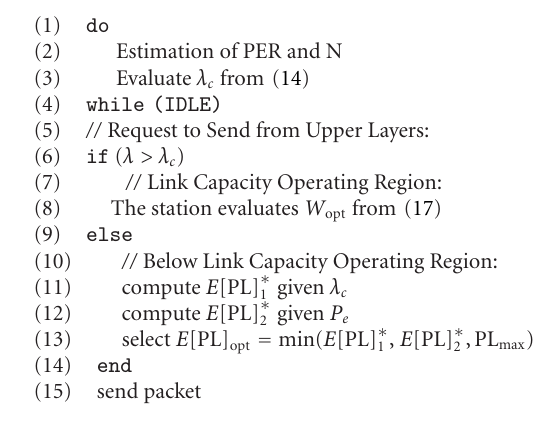
Algorithm 1: Optimization algorithm accomplished by every contending